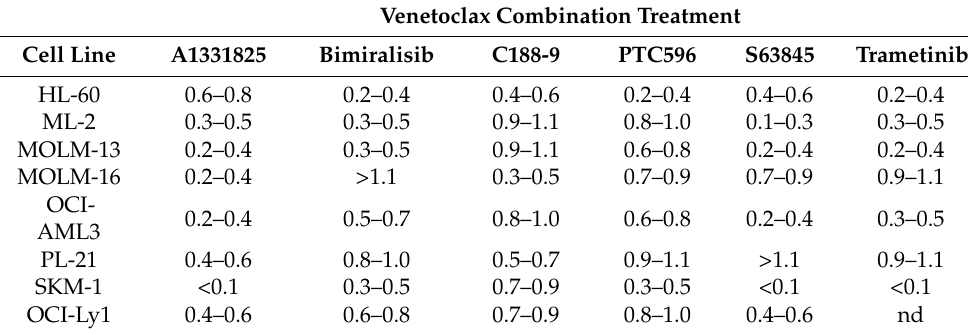
Table 3. Combination index values of AML cell